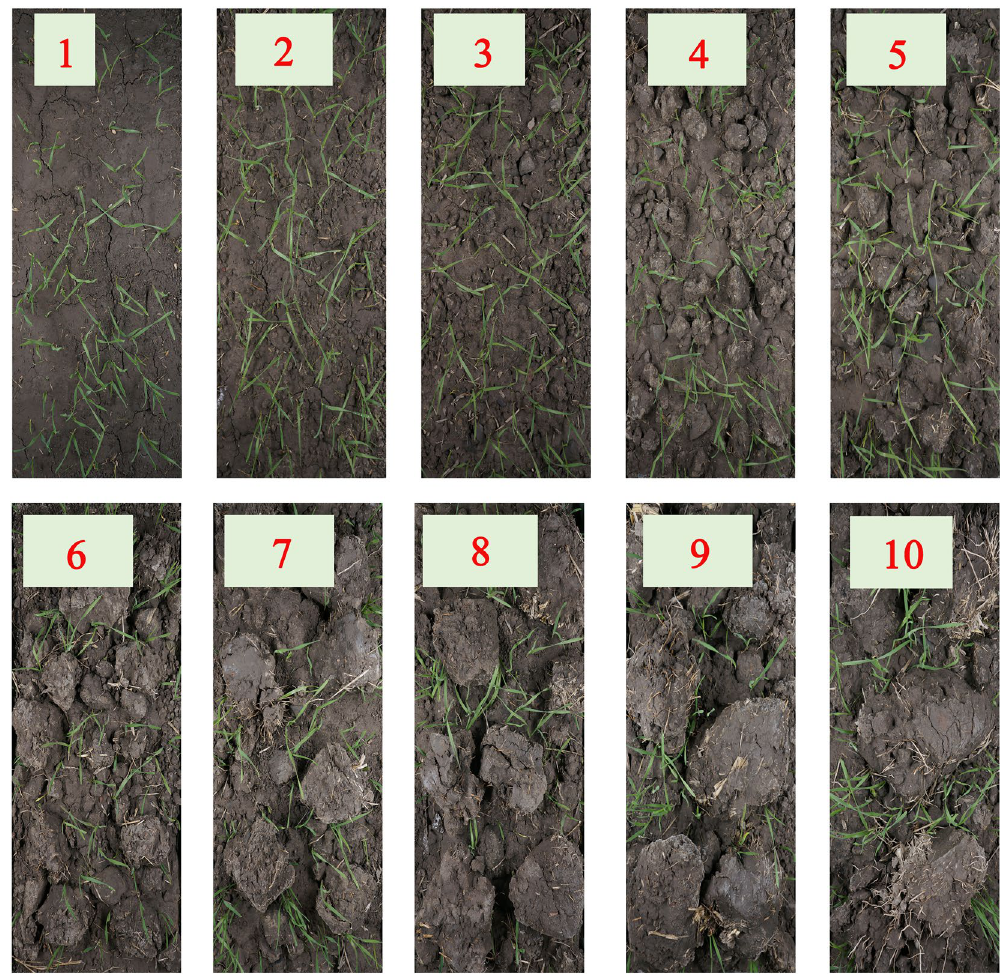
Figure 7. Emergence efficiencies of different grades of cultivated